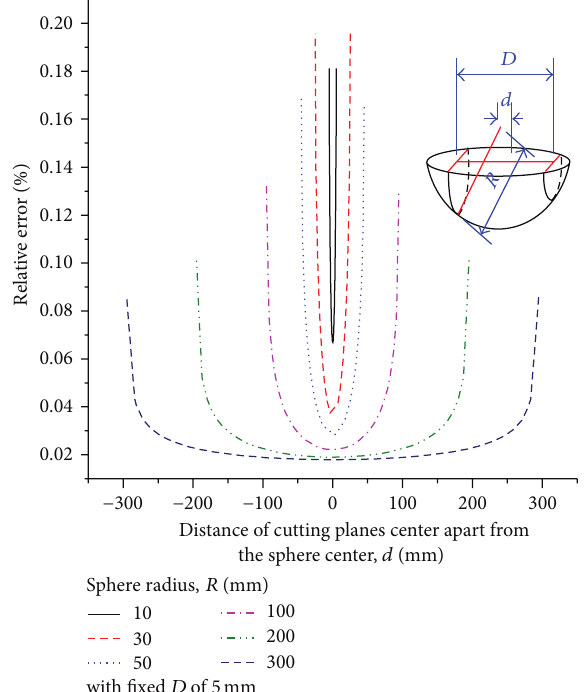
Figure 3: Profiles of the relative error for various ROC ( 𝑅 ) values with distance ( 𝑑 ) of the cutting planes center from the sphere center, where 𝐷 is distance between two cutting